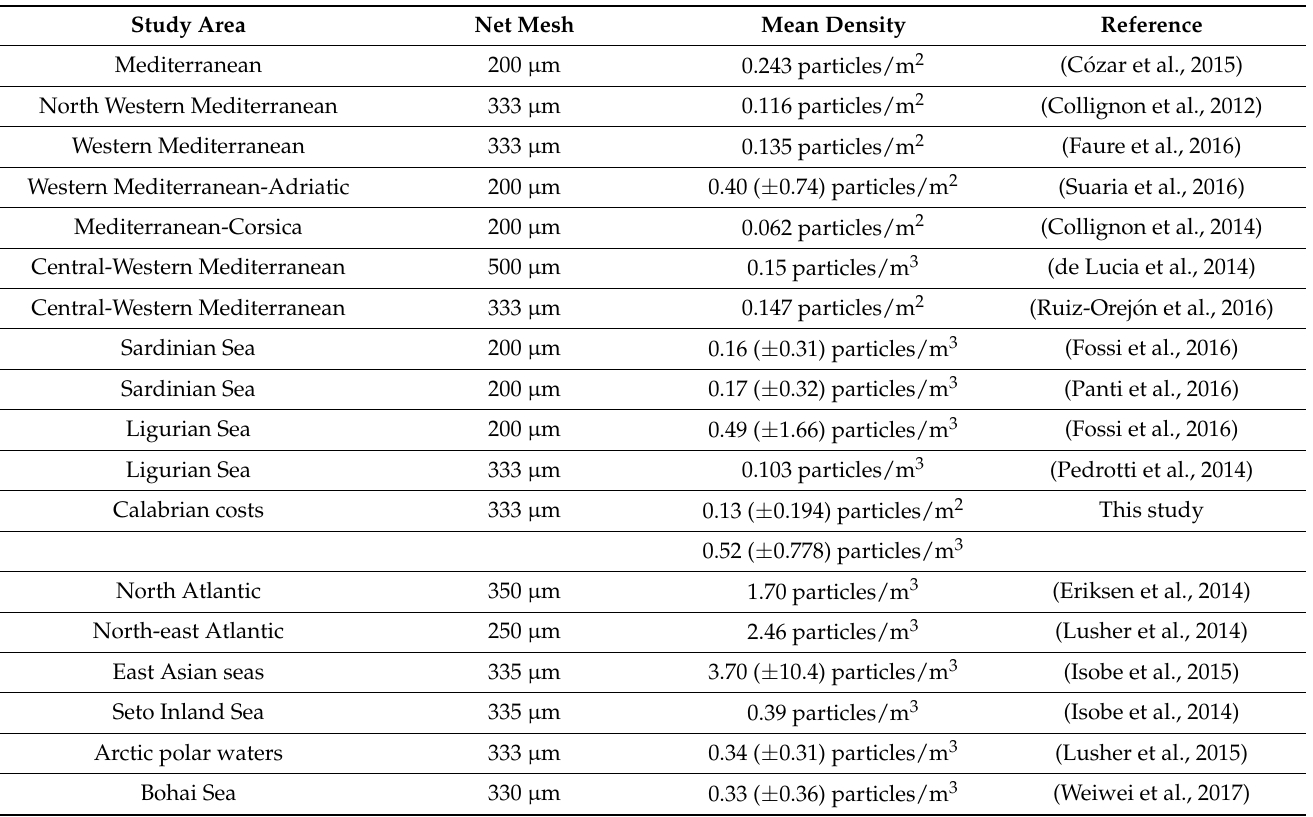
Table 1. Microplastic concentrations in marine